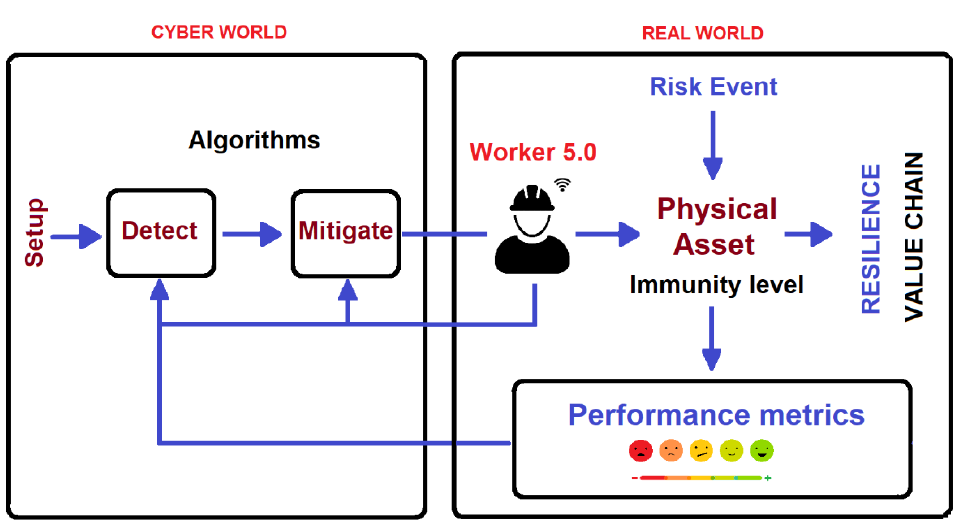
Figure 6. General human-in-the-loop control framework for maintenance 5.0.